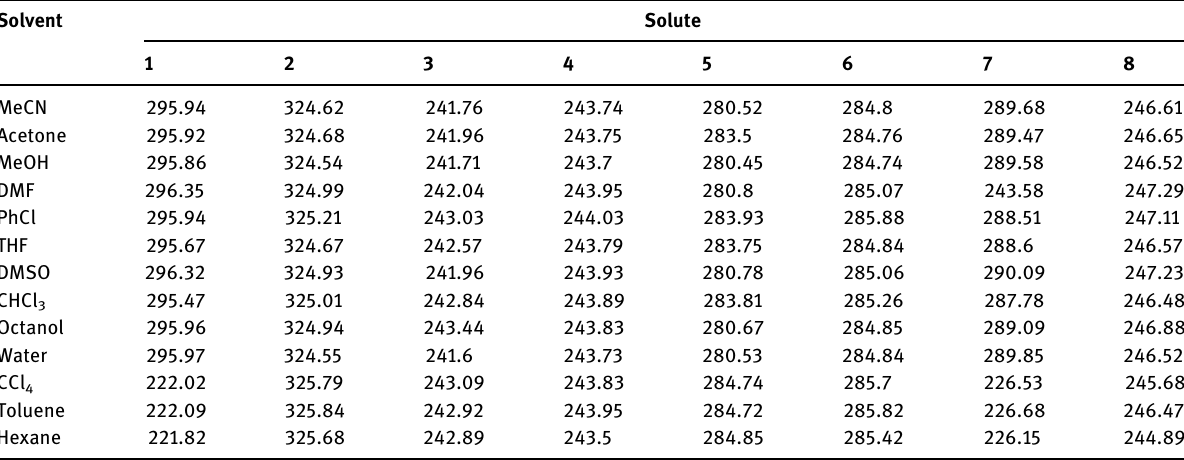
Table 6: Calculated values of λ max ( nm ) for azoles 1 – 8 at the B3LYP/6 - 311 ++ G ( 2d,3p ) //B3LYP/6 - 31G ( d,p ) level of theory using di ff erent solvents and PCM solvation model.